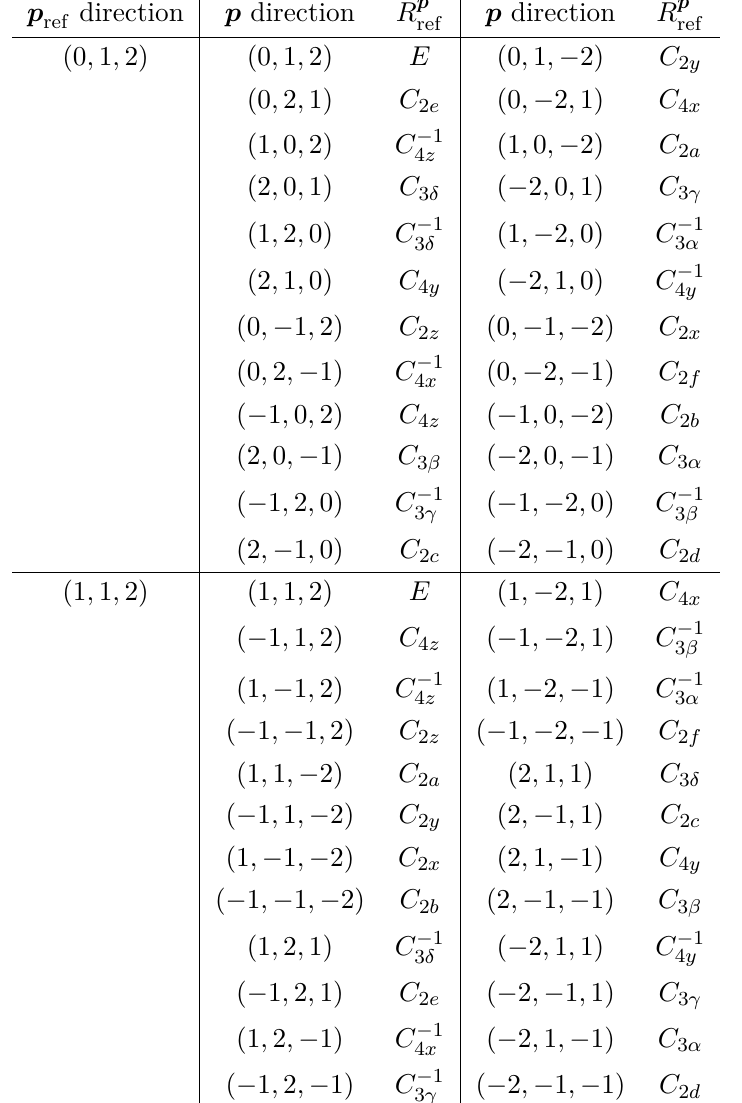
Table 18. Our choices for the reference momentum p for each of the additional momentum p directions that we use. See table II of ref. [44] for all other momentum directions used. See ref. [44] for definitions of the rotation operators C nj below. E is the identity